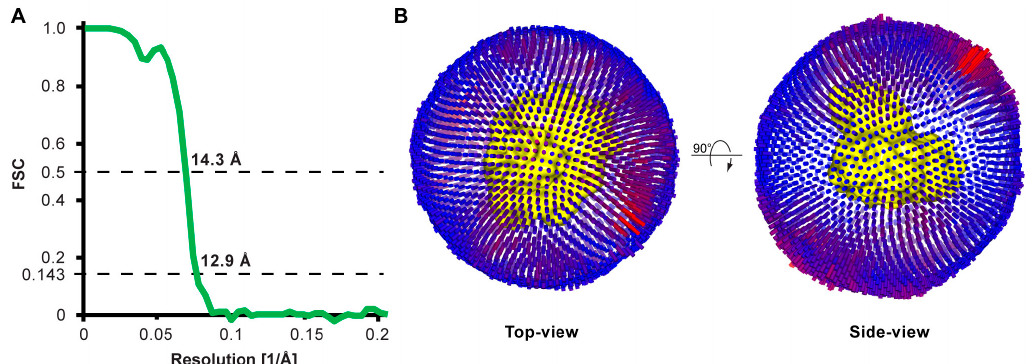
Figure 3. Resolution estimation and angular particle distribution. ( A ) The Fourier shell correlation (FSC) plot for the calculated 4F2hc-LAT2 3D-map indicated resolutions of 14.3 Å and 12.9 Å at cut-offs of 0.5 and 0.143 (gold standard), respectively. ( B ) Angular distribution plots of particles included in the final 3D reconstruction viewed from the top and the side. The number of particles with respective orientations are represented by length and colored cylinders, ranging from blue to red. In the center, the cryo-EM 3D-map of 4F2hc-LAT2 is represented as yellow colored surface.